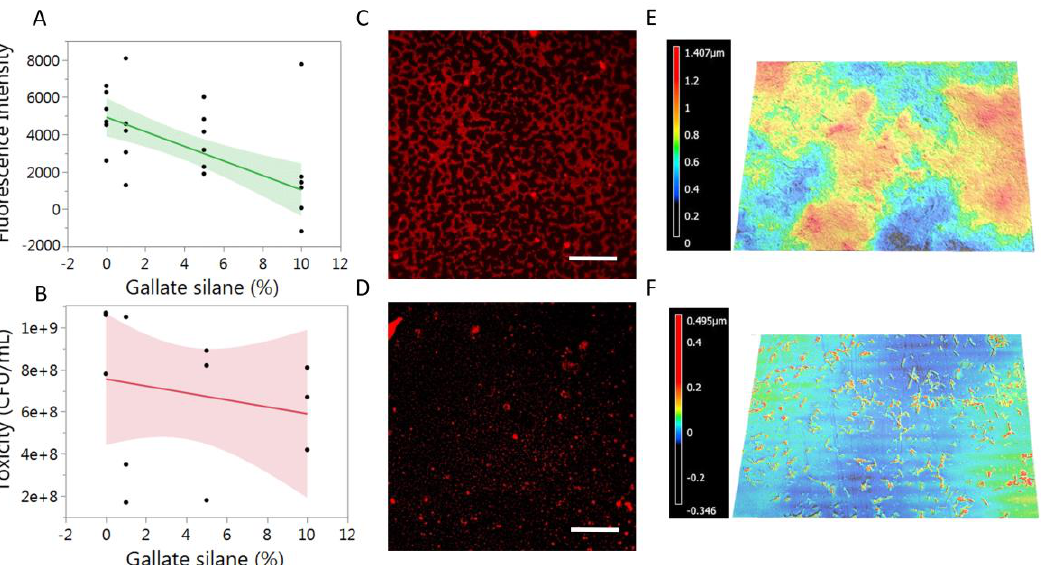
Figure 4. Fluorescence was measured from stained Sulfitobacter sp. biofilms on glass treated with ( A ) various concentrations of gallate–silane and ( B ) bacteria concentration (CFU/mL) of the inoculating culture after 24-h exposure to the silane coatings. Fluorescent microscope images ( C , D ) and Keyence height profiles ( E , F ) of glass slides with ( top ) 0% gallate–silane and ( bottom ) 5% gallate-silane (scale bar 50 µM).